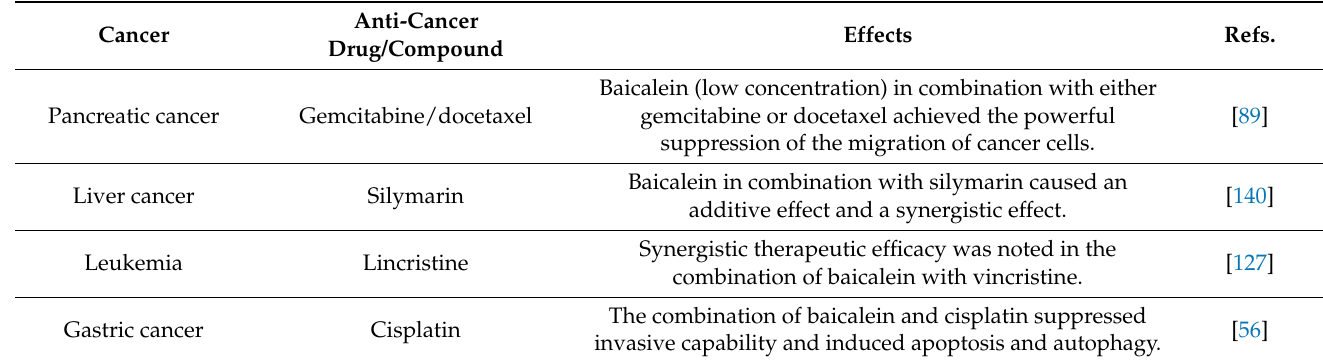
Table 4. Synergistic effect of baicalein in combination with anti-cancerous